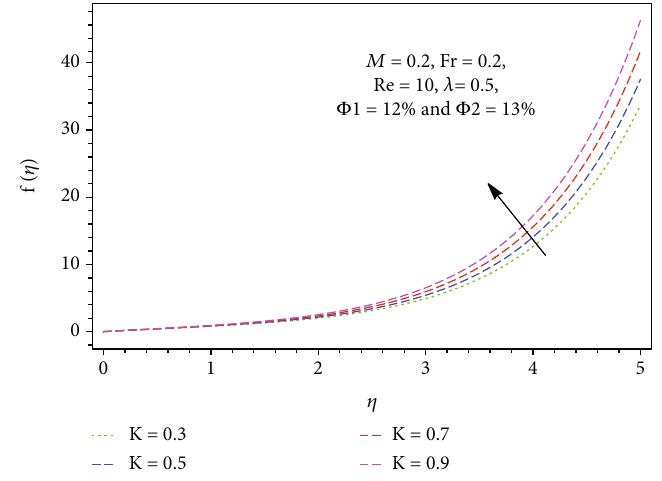
Figure 3: In fl uence of couple stress parameter K over momentum pro fi le f ð η Þ .